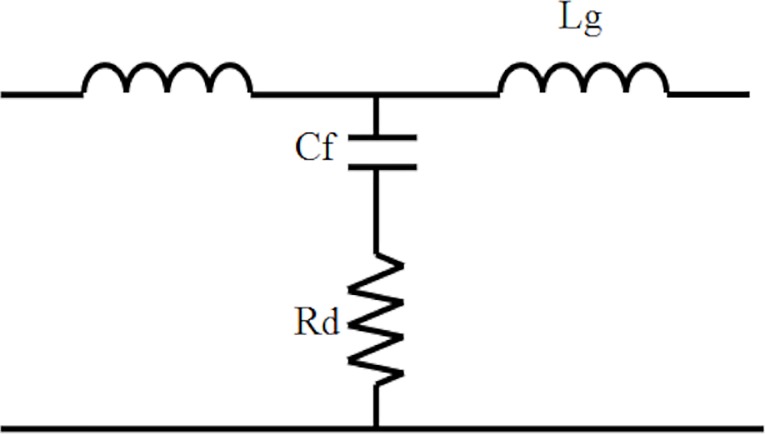
LCL filter model.